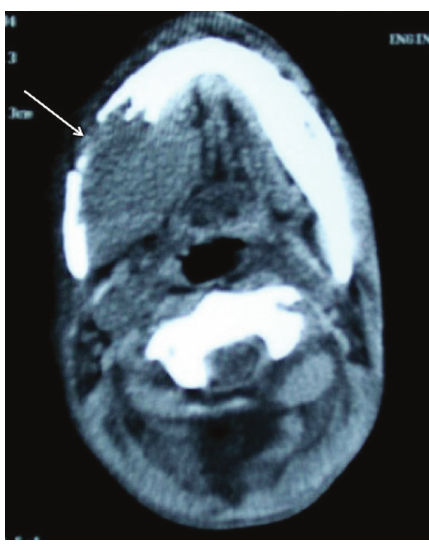
Figure 3: A CT scanning showed a mass with a diameter of 5cm infiltrating the retromolar and posterior buccal areas with an erosion the mandibular alveolar ridge.